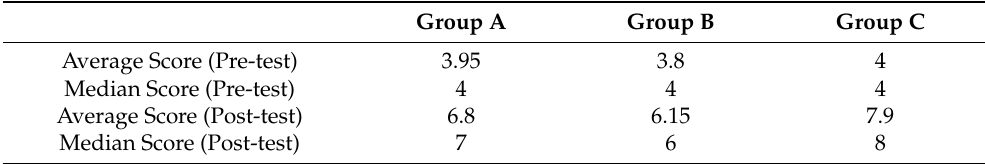
Table 4. Average and median score data in each